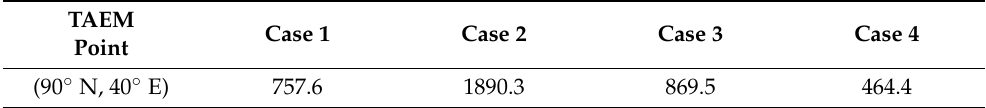
Table 10. The drop point error of low energy cases